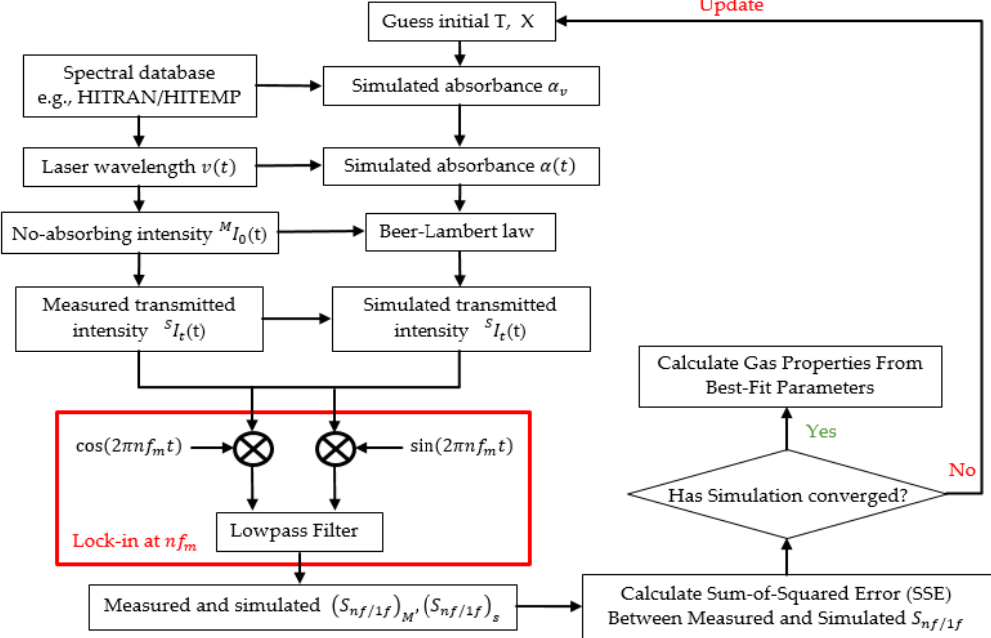
Figure 5. Flow chart of a calibration-free WMS scheme with scanned-wavelength laser characterization.